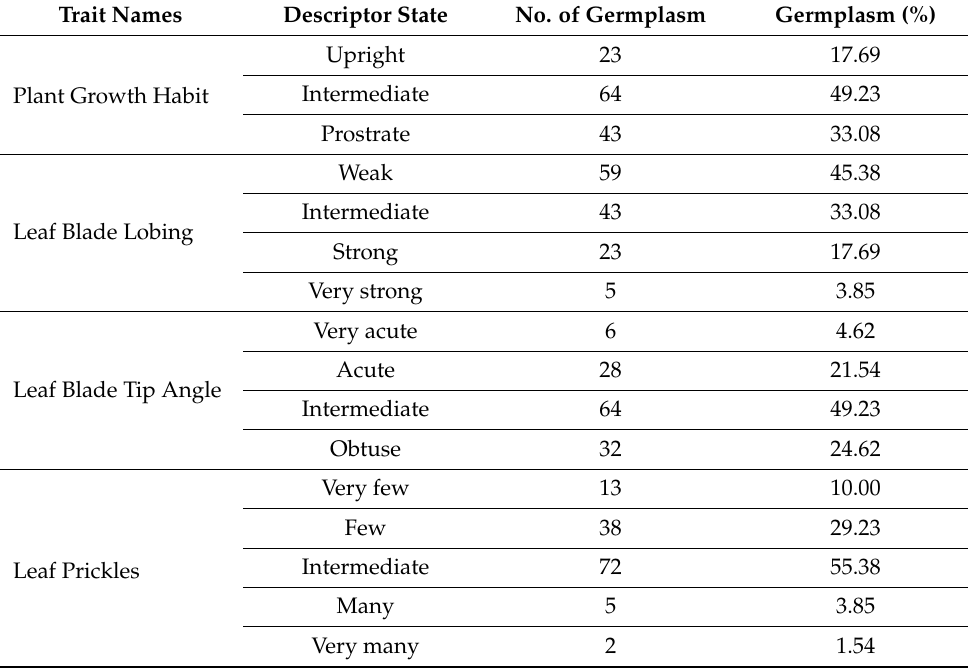
Table 2. Variability in growth and foliage traits in eggplant